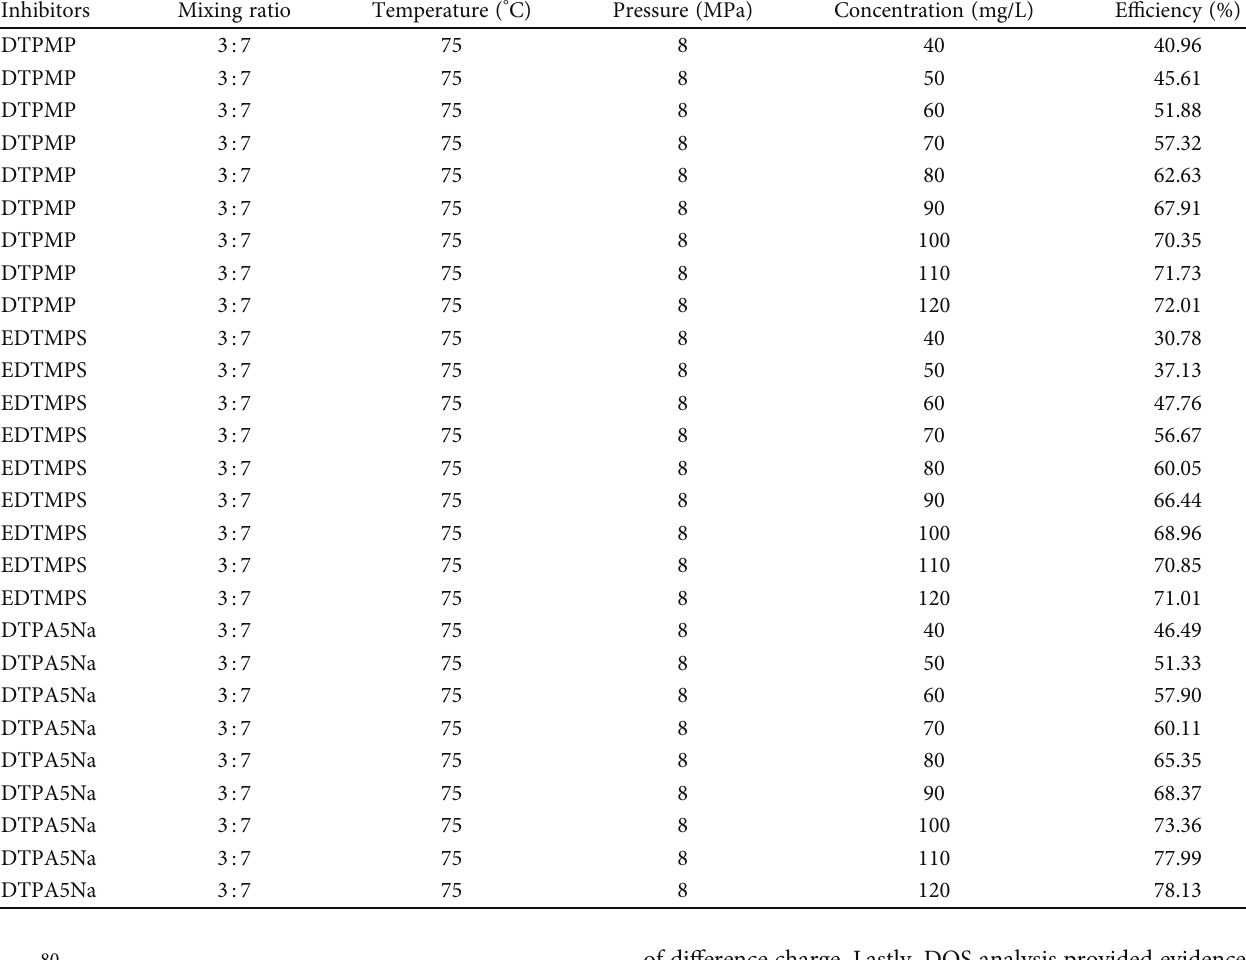
Table 3: E ffi ciency of inhibitors at di ff erent concentrations.